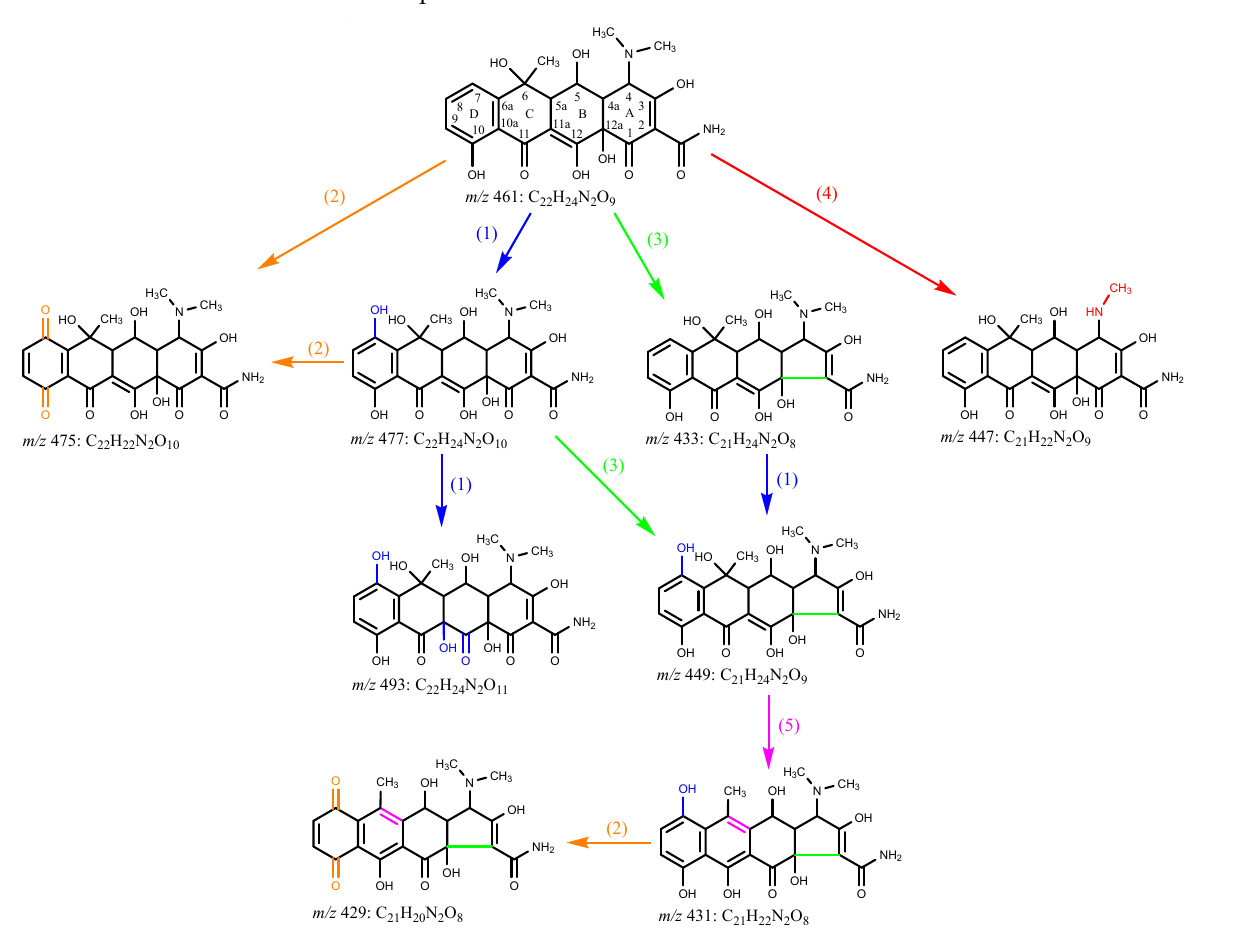
Figure 9. Probable photolytic and TiO 2 -assisted photosensitized degradation mechanisms of OTC under visible light irradiation at pH 8.6: (1) hydroxylation, (2) quinonization, (3) decarbonylation, (4) demethylation, and (5) dehydration. Experimental conditions: [OTC] 0 = 10 mg L − 1 , [TiO 2 ] 0 = 0.5 g L − 1 , 50 mM phosphate buffer.